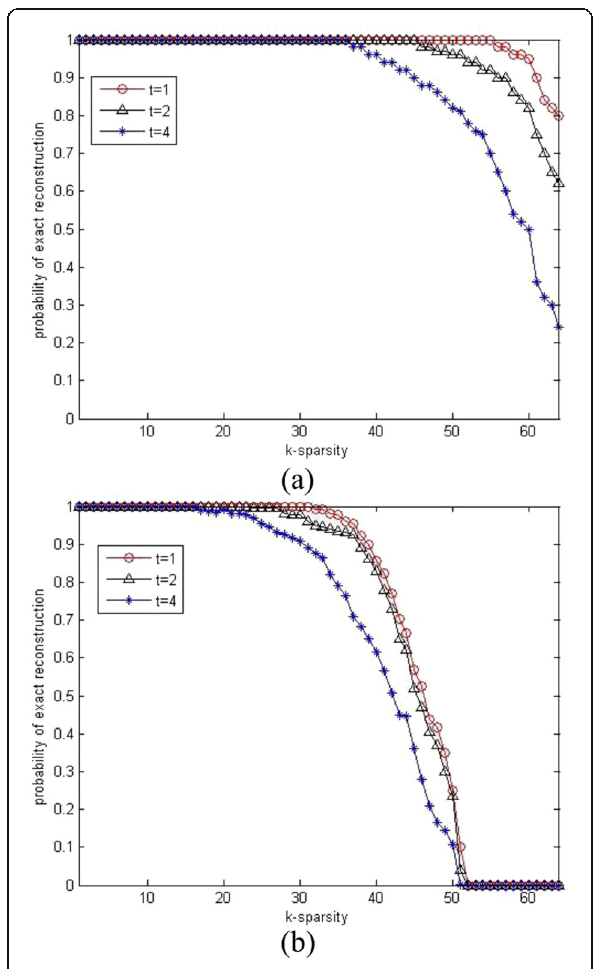
Fig. 1 Comparison of probabilities of exact reconstruction with different dimensions of measurement matrices ( M = 128, N = 256). Frame a is obtained from l 0 -norm minimization with ρ = 0.8. Frame b is obtained from l q -norm minimization with q = 0.8 and ρ = 0.8. In frame a and b , t = 1, 2, 4 mean the dimensions of the measurement matrices are 128 × 256, 64 × 128, and 32 × 64,